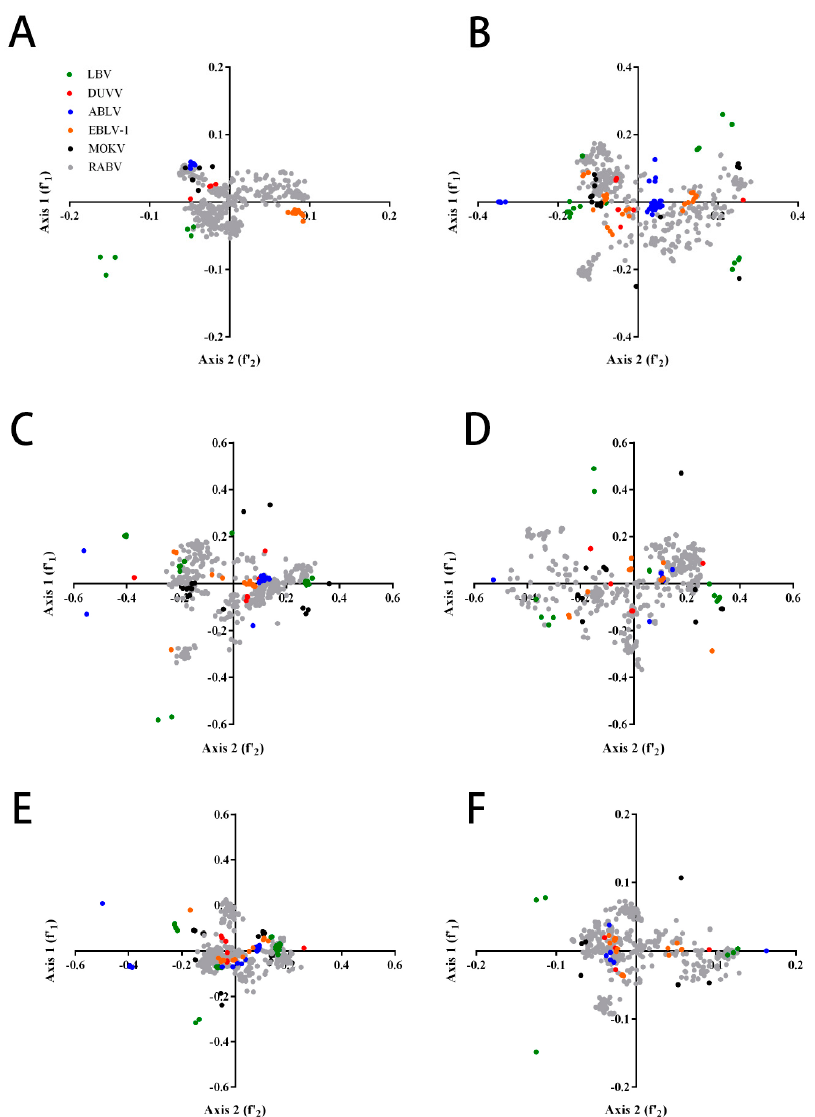
Figure 2. Principal component analysis. Species-specific PCA plots were constructed for whole genome and individual lyssavirus coding sequences. ( A ) Whole genome; ( B ) N; ( C ) P; ( D ) M; ( E ) G; ( F ) L. The color coding is the same as that of ( A ).